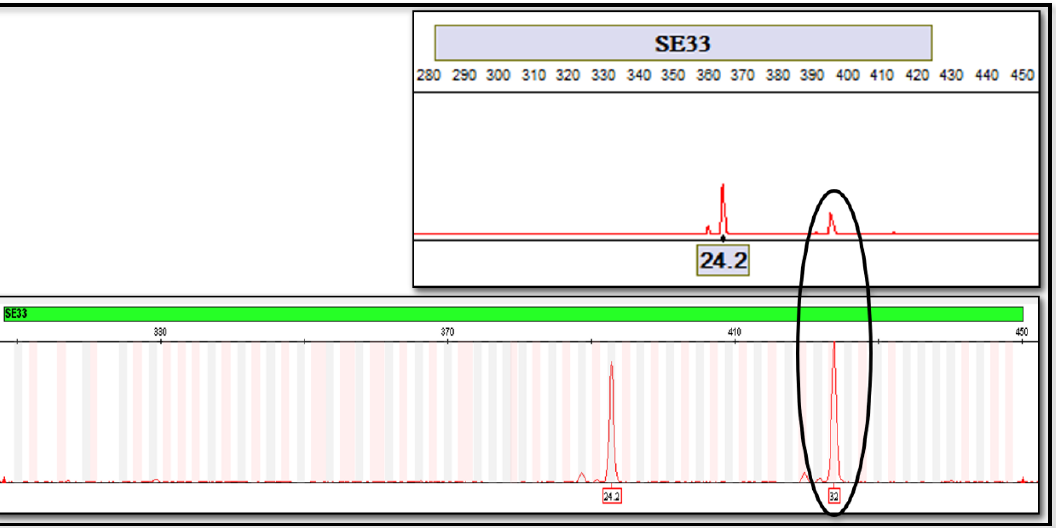
ff -ladder at the SE33 Figure 2. The off-ladder at the SE33 marker. Figure 2. The o